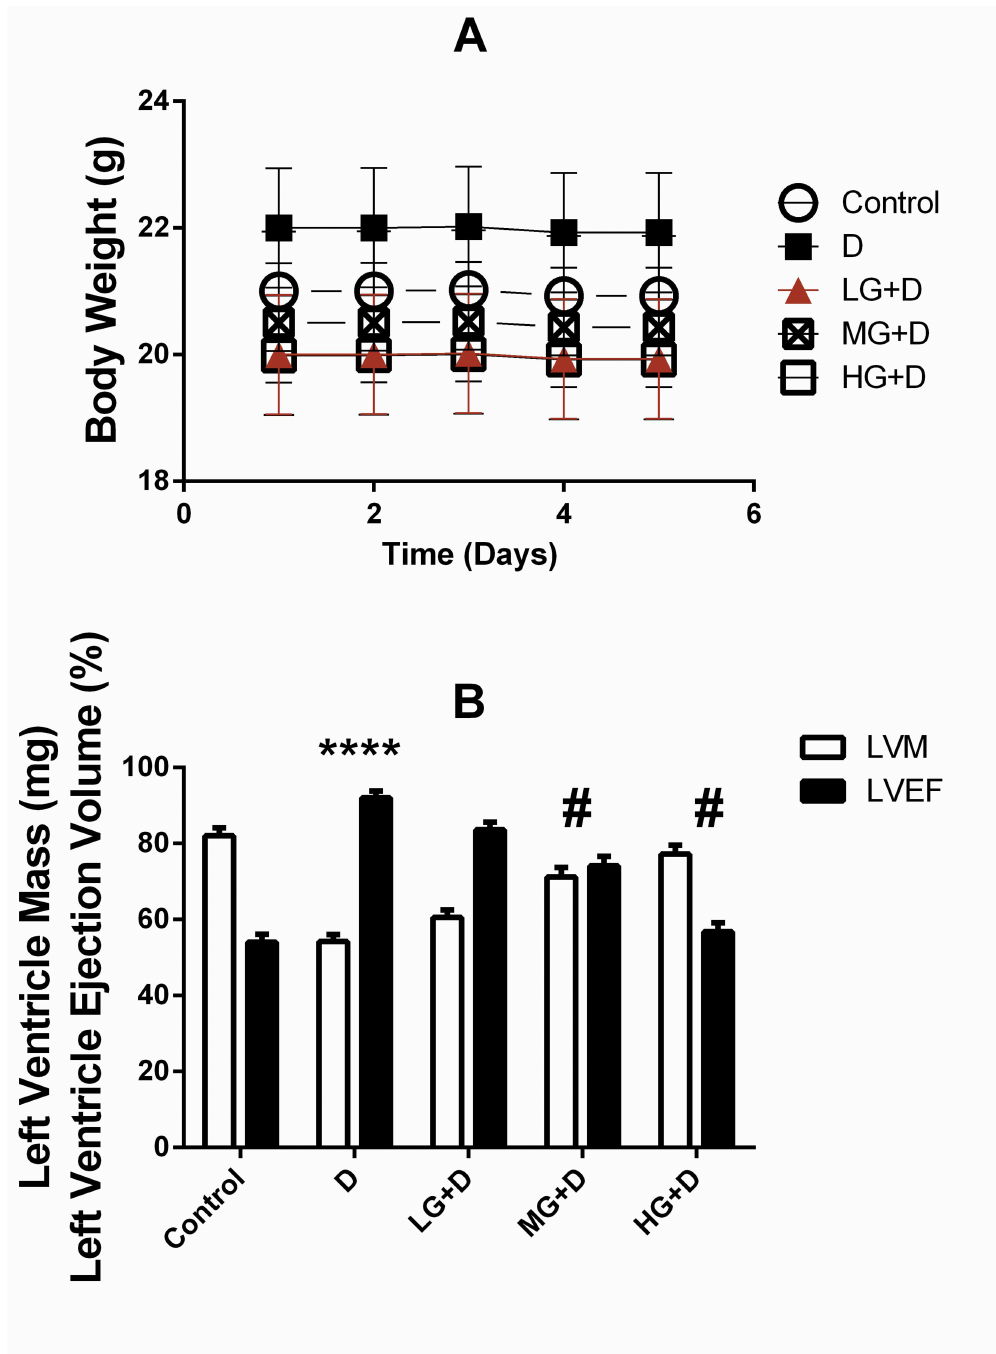
Fig 7. Protectiveeffect of GB on cardiac function in DOX induced cardiotoxic model in vivo . ( A ) No significantdifference was recordedregardingmouse weight in mice treated with DOX, GB or both. ( B ) Significant improvement of the left ventricleejection fraction (LVEF) and decreasedleft ventricle mass (LVM) were found in mice treated with GB in DOX-induced cardiotoxic model. **** p < 0.0001 when comparedto control group, #p < 0.05 when comparedto